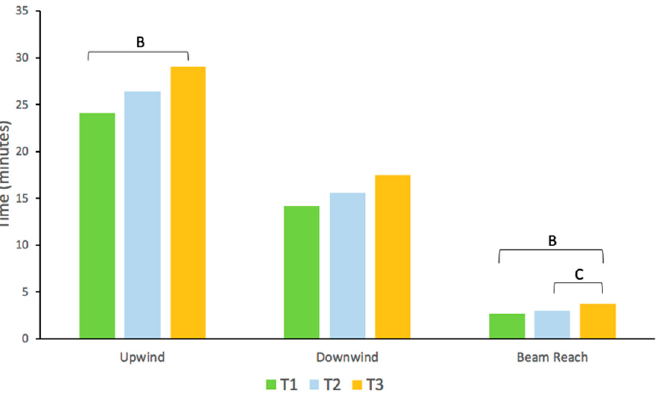
Figure 4. Comparison between the groups of sailors with different performance levels (T1, T2, and T3) in upwind and beam reach for time. B : statistically significant difference between T1 and T3; C : statistically significant difference between T2 and T3; T1: high-level sailors; T2: medium-level sailors; T3: low-level sailors.